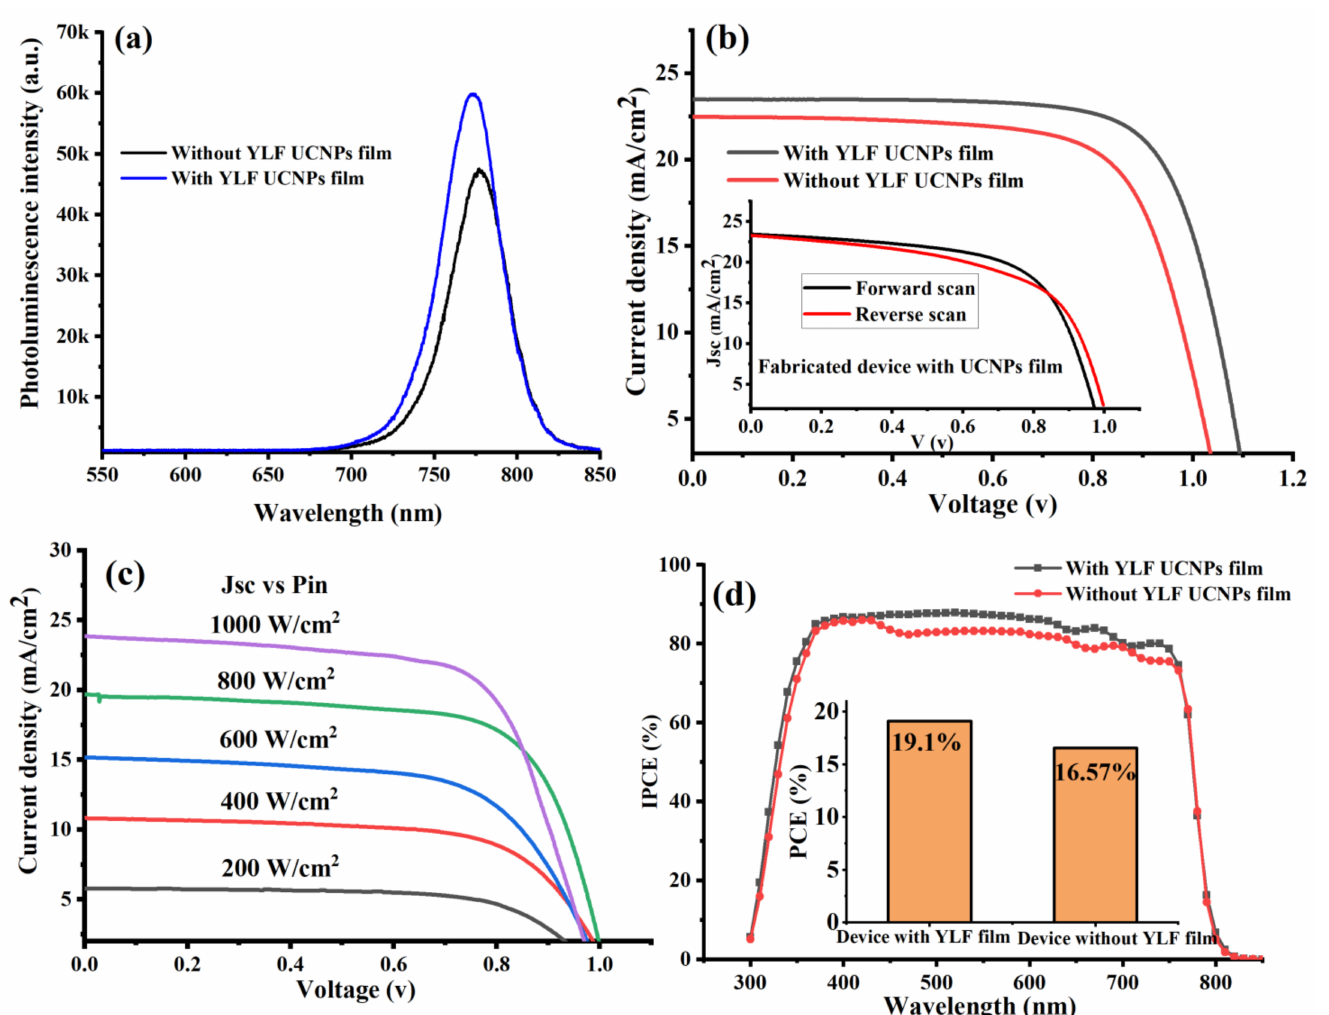
Figure 3. ( a ) Shows the photoluminescence spectra of perovskite films in PSCs with and without UC thin-film coating. ( b ) J-V characteristic curves measured under AM 1.5 G for fabricated PSCs with and without UC thin films. ( c ) A comparison chart of power conversion efficiency (PCE) of fabricated UC-PSC device and pristine device. ( d ) Quantum efficiency (IPCE) spectra of fabricated PSCs with and without UC thin